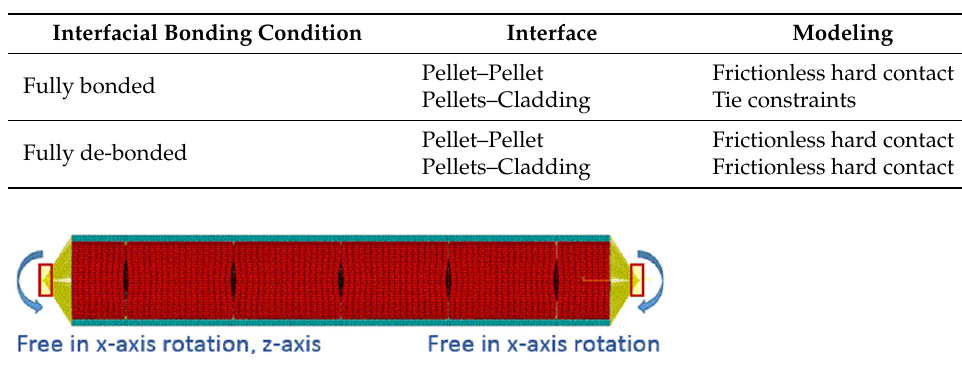
Figure 7. Constraints of the detailed fuel rod.